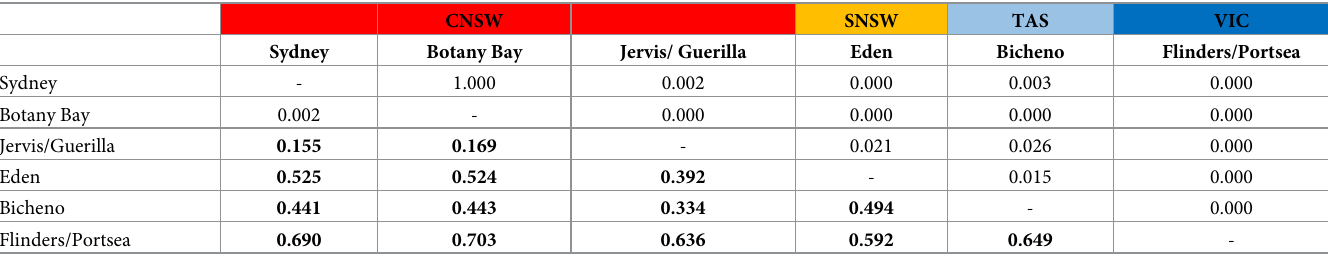
Table 1. Pairwise F ST values between populations of P . taeniolatus